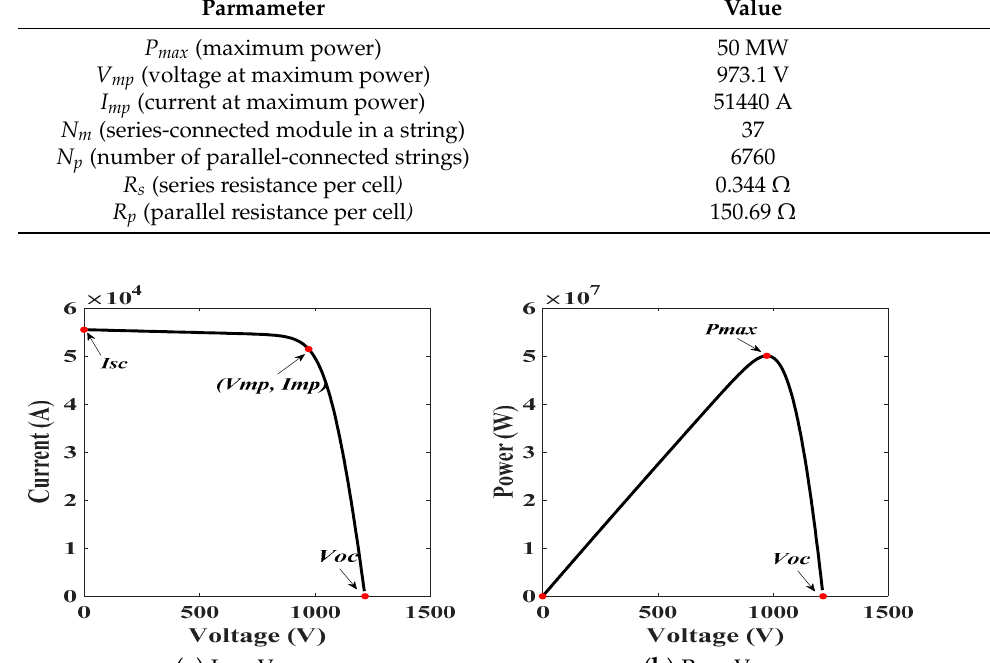
Table 1. Designed parameters of a 50 MW PV station.